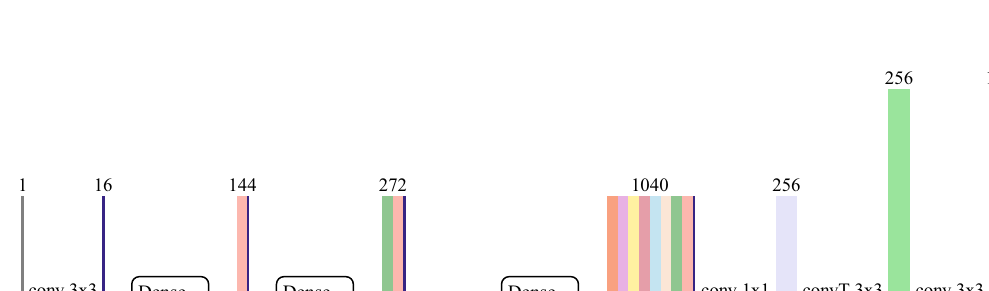
Figure 1. A dense block, which is a fundamental component of the SRDenseNet architecture, contains eight convolutional layers that receive the outputs of all preceding layers as input.